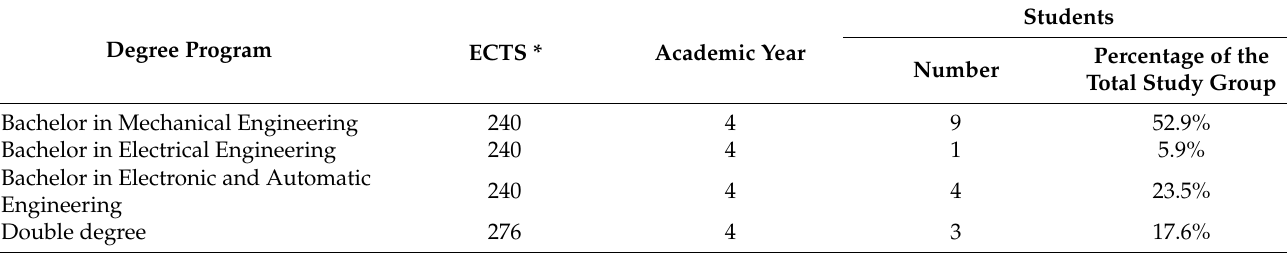
Table 1. Distribution of the